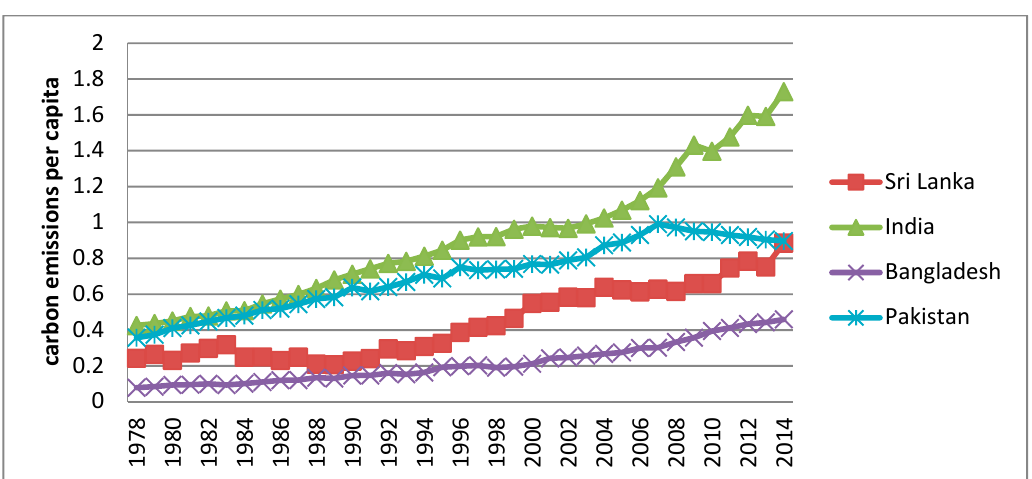
Figure 3. Carbon emissions per capita in selected South Asian countries.